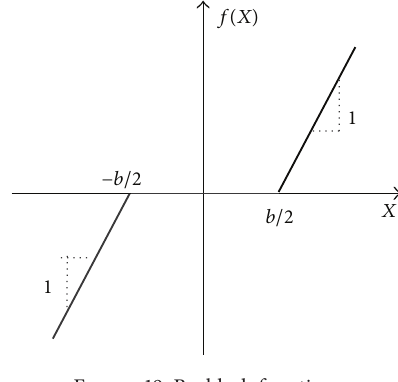
Figure 19: Backlash function.